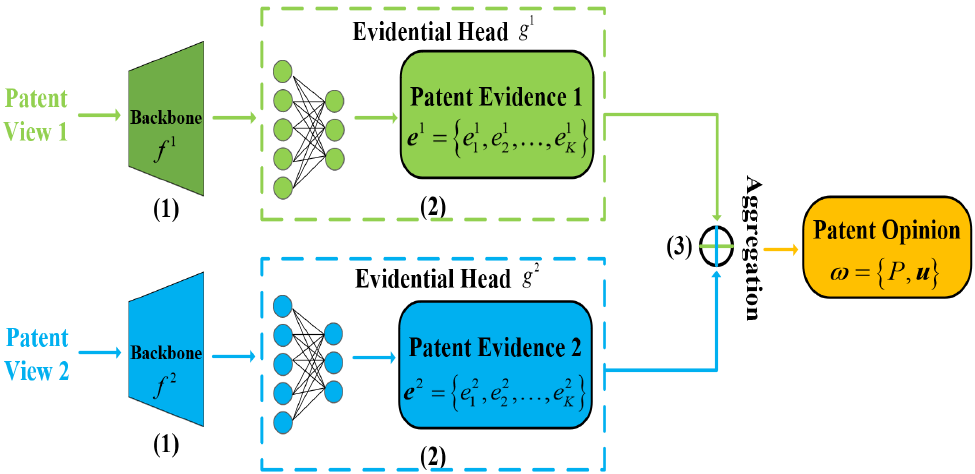
Figure 1. The framework of the reliable multi-view deep patent classification (RMDPC) method. (1) The patent embedding representation of each patent view is captured by backbone neural net- works. (2) The estimated evidence from each patent embedding representation is obtained using the evidential head. (3) The evidence from different patent views is accumulated and combined into one unified evidence based on the aggregation strategy with evidence theory and then the aggregated evidence is transformed into a patent opinion that contains the belief and uncertainty degrees based on evidence